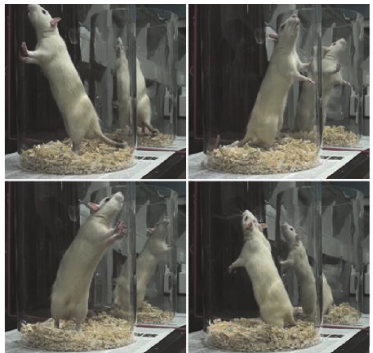
Figure 2: The cylinder test. Contacts were recorded if the rat contacted the cylinder wall once with a foreleg unilaterally, or kept this foreleg in contact with the cylinder wall, and then touched the cylinder wall with another leg, or contacted the cylinder wall with both forelegs at the same